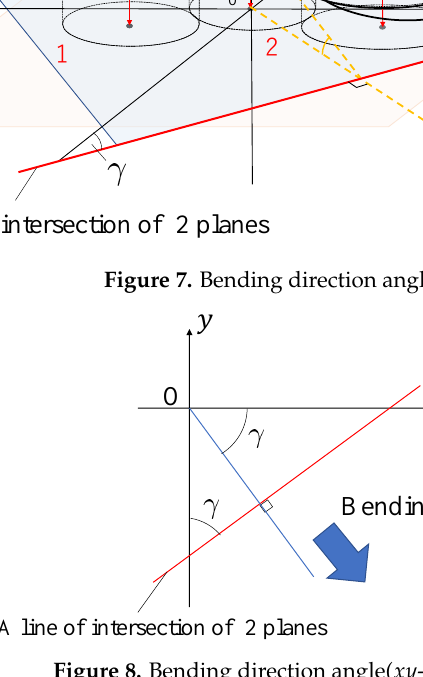
Figure 8. Bending direction angle( xy